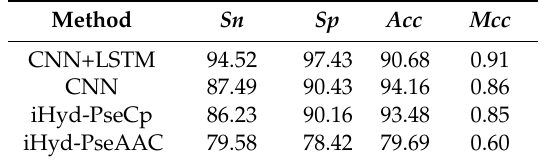
Table 1. A comparison of predictors for identifying hydroxyproline sites on Dataset 1.